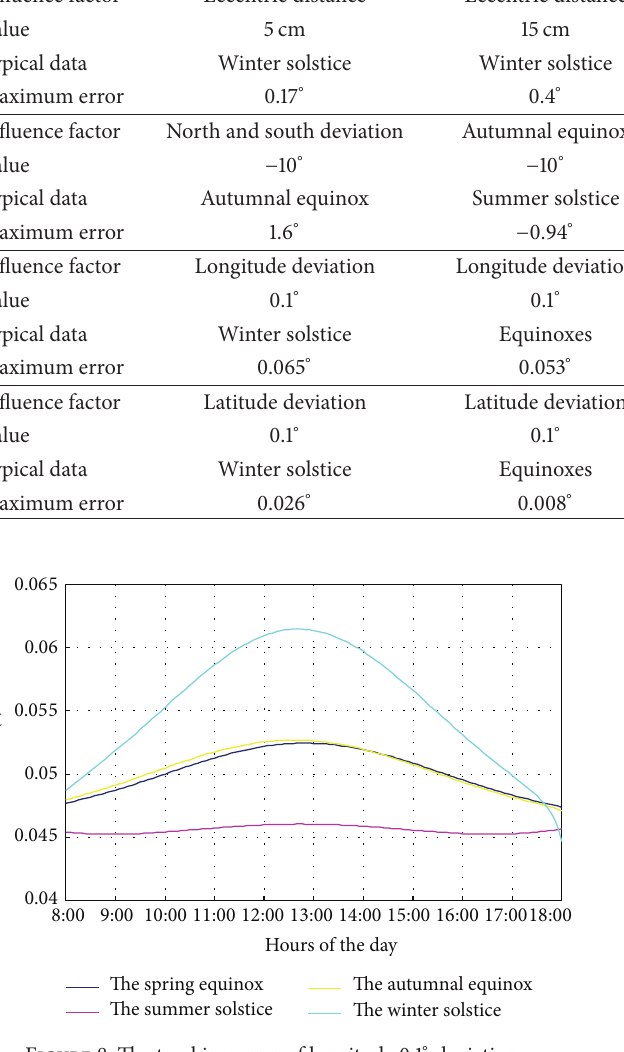
trend at vernal equinox and autumnal equinox are consistent.